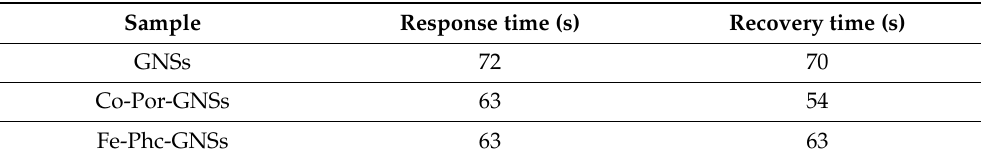
Table 1. Responsivity and recovery time of pristine GNS and functionalized GNS gas sensors exposed to 0.5 ppm of NO 2 at room